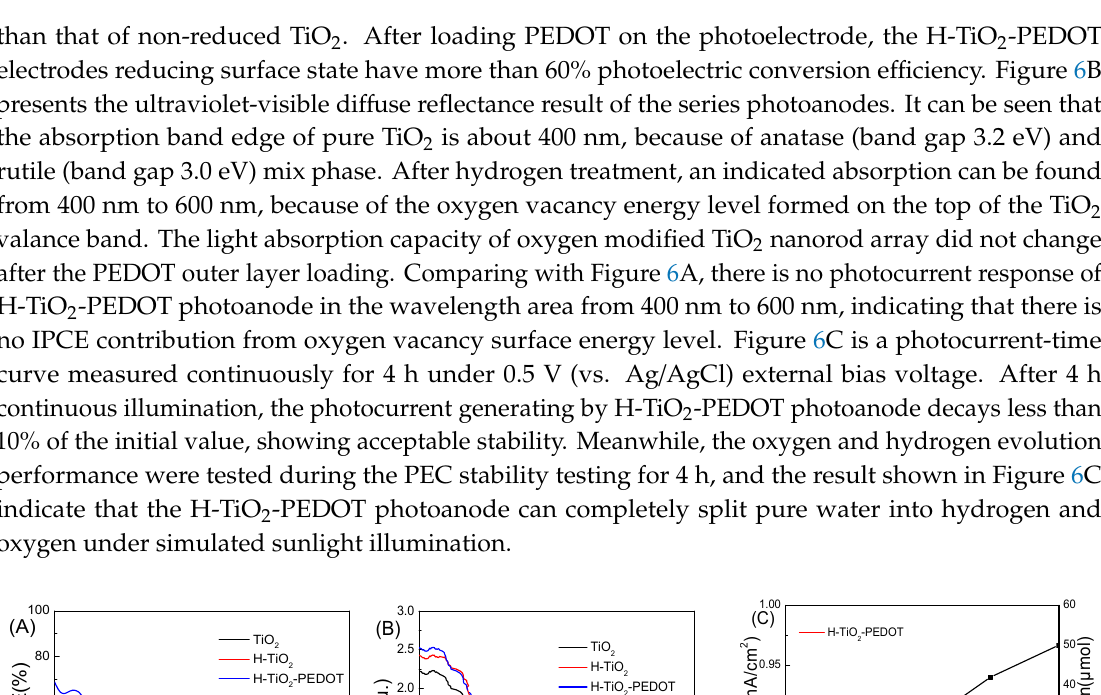
Table 2. Statistical list of